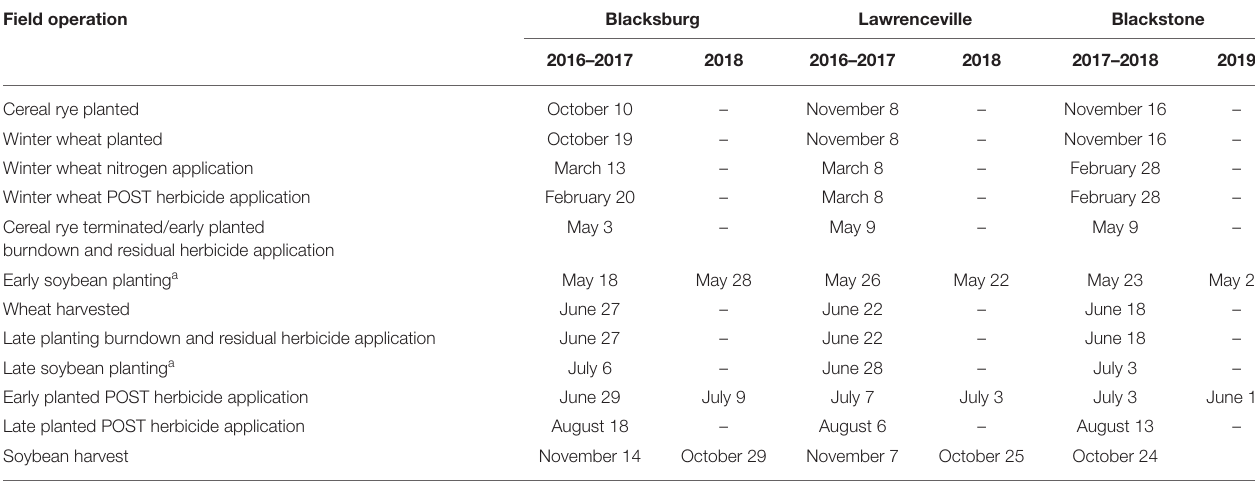
TABLE 1 | Dates for cover crop and soybean planting, cover crop termination, POST herbicide application, and soybean harvest for all locations and years of the